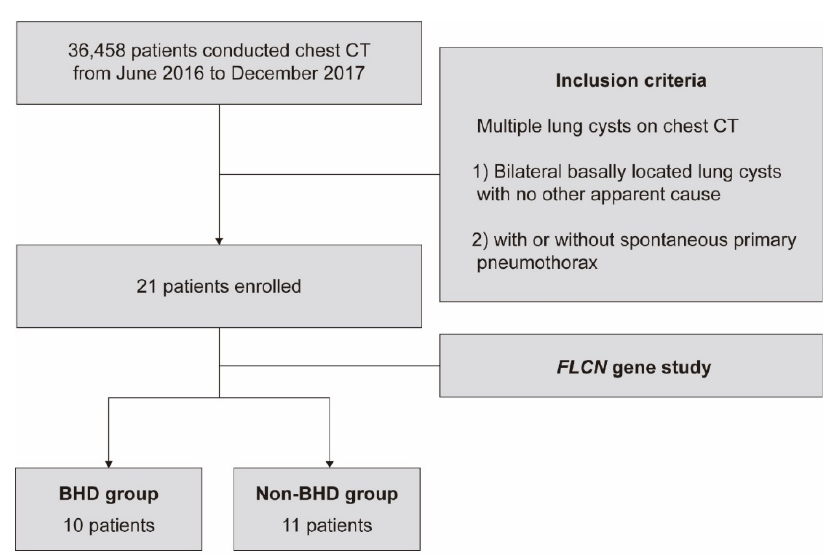
Figure A1. Flow chart of patient selection.